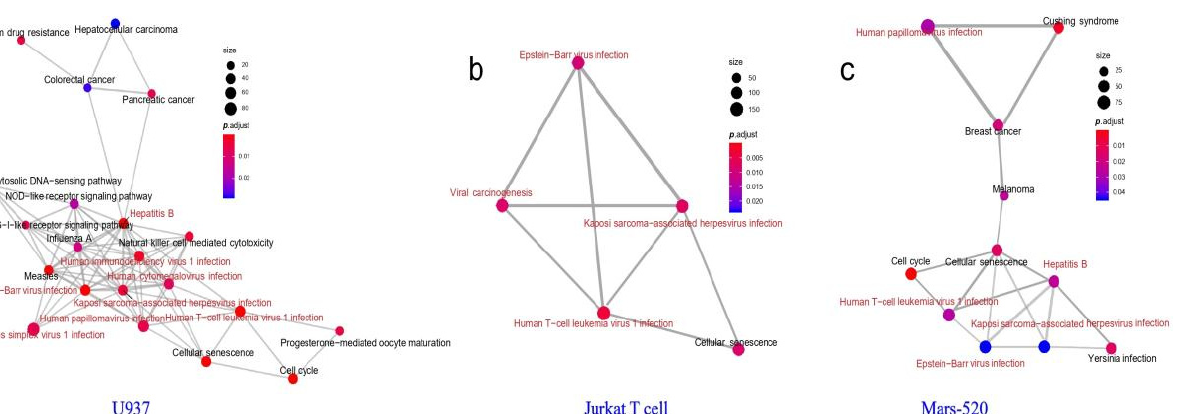
Figure 5. The intersection of the viral infection pathways enriched in Mars 520, Jurkat T and U937 cells. In the KEGG enrichment results of Mars 520, Jurkat T and U937 cells of differential expression genes, EBV infection pathway, KSHV infection pathway and HTLV1 infection pathway appeared simultaneously in the three groups of chips; HPV pathway infection and HBV infection pathway appeared simultaneously in Mars 520 and Jurkat T cells; HSV1 infection pathway appears in Jurkat T cells and U937 cells.